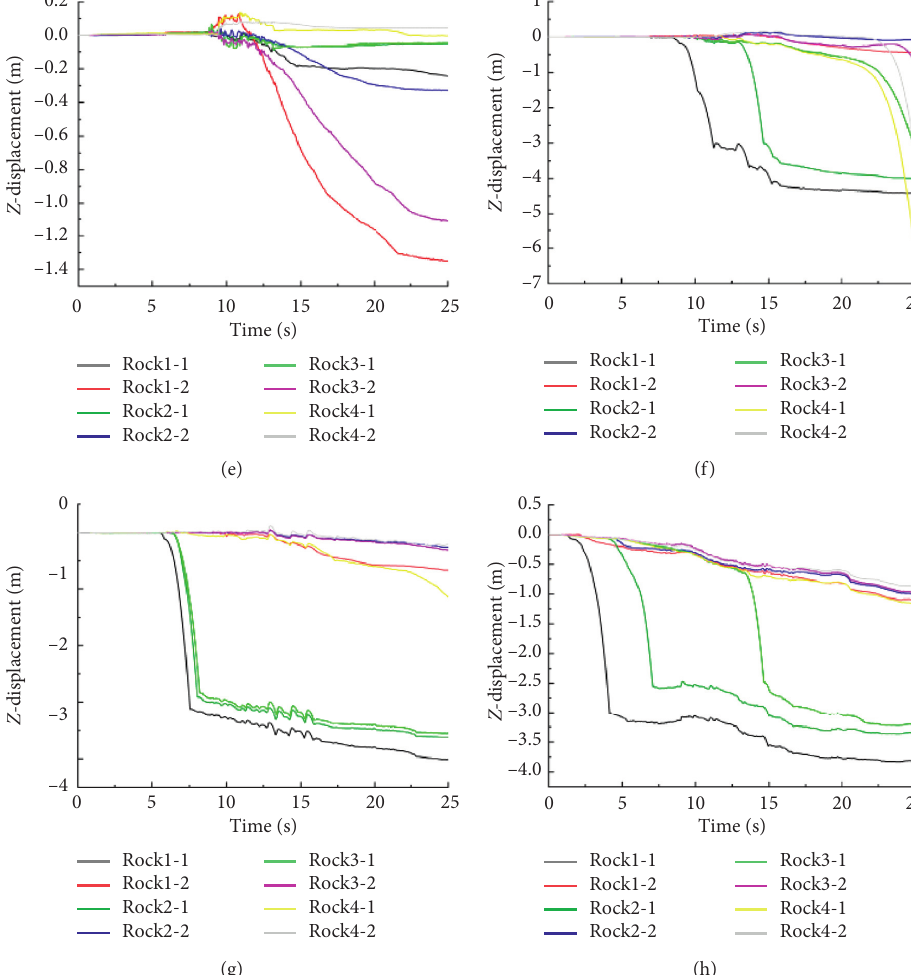
Figure 13: Displacement time history curve of each model. (a) Model 1, y -direction. (b) Model 2, y -direction. (c) Model 3, y -direction. (d) Model 4, y -direction. (e) Model 1, z -direction. (f) Model 2, z -direction. (g) Model 3, z -direction. (h) Model 4, z